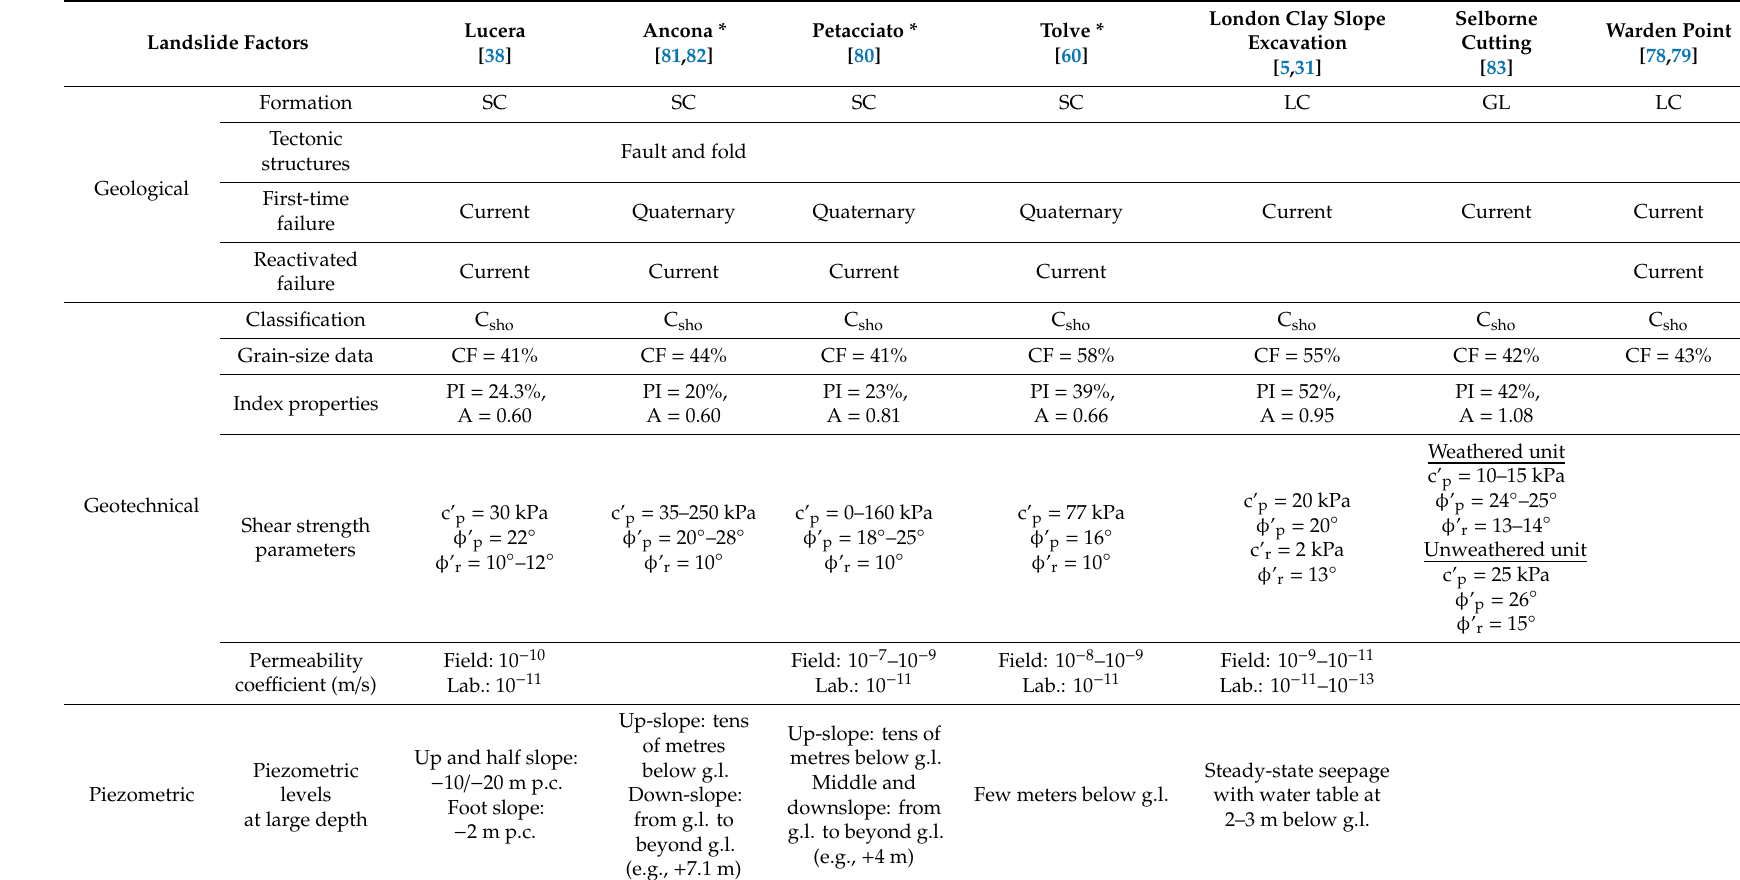
Table 3. Landslide factors of some landslide mechanisms belonging to class 1 (Figure 11); Key: CF—clay fraction, PI—Plastic Index, A—activity, peak shear